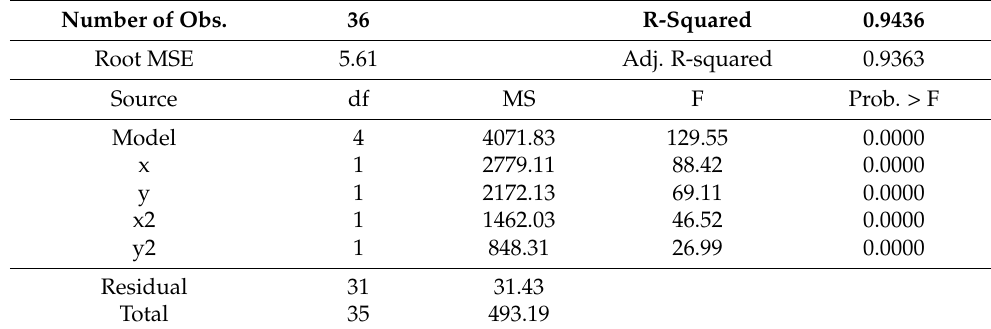
Table 11. ANOVA analysis with all items but the xy.